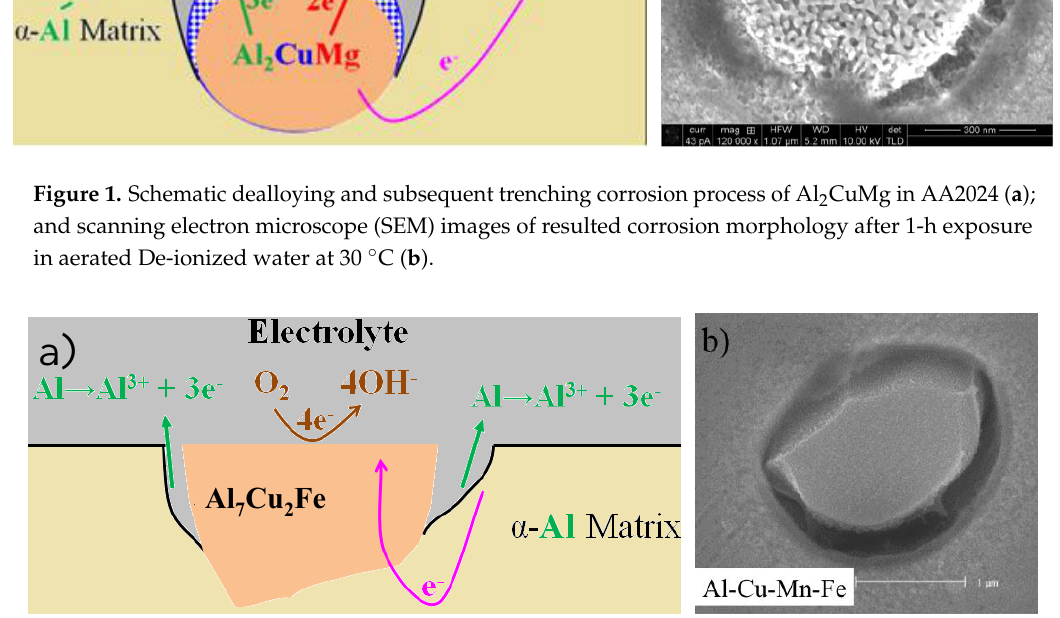
Table 1. Corrosion potential, pitting potential and corrosion current density of Al-rich solid solution and second phase particles.